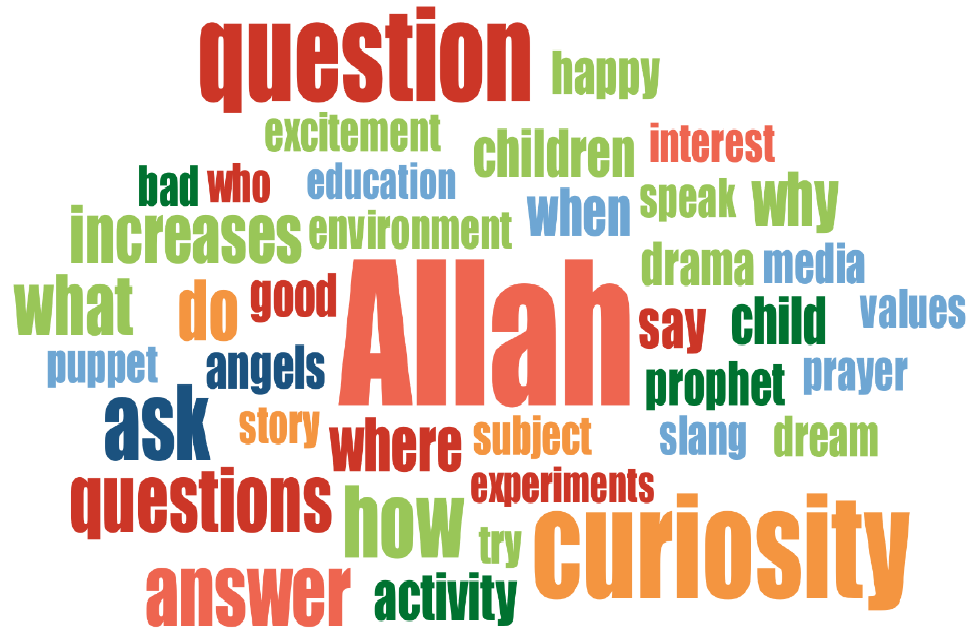
Figure 1. Word cloud consisting of participant views on preschool children’s curiosities on religious and moral issues.